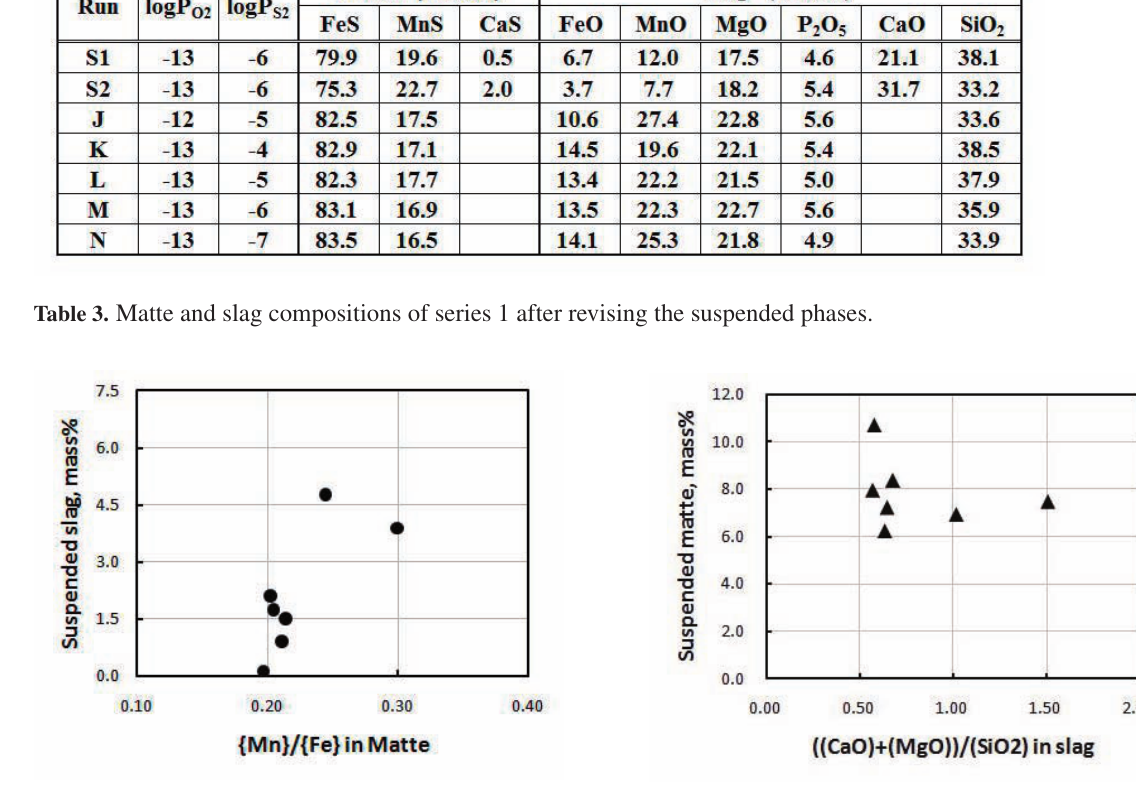
Figure 7. Total amount of suspended slag within matte as a function of ¹ Mn º = ¹ Fe º of matte in Table 3.